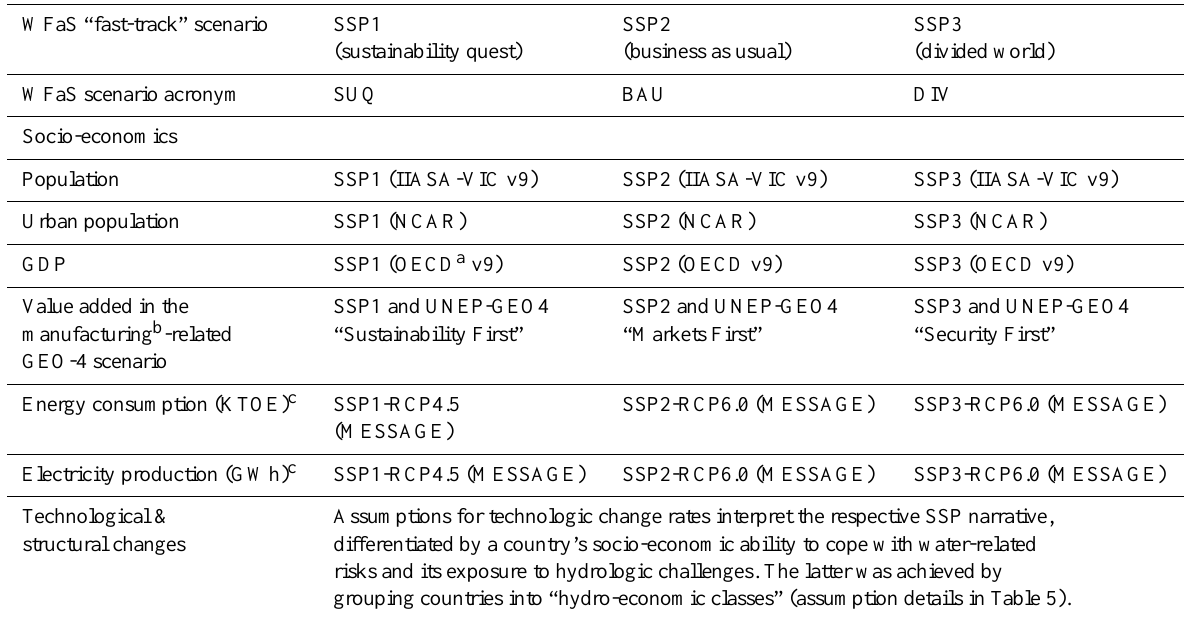
Table 4. Assumptions applied in the WFaS “fast-track” scenario runs, deployed at country level. WFaS “fast-track”